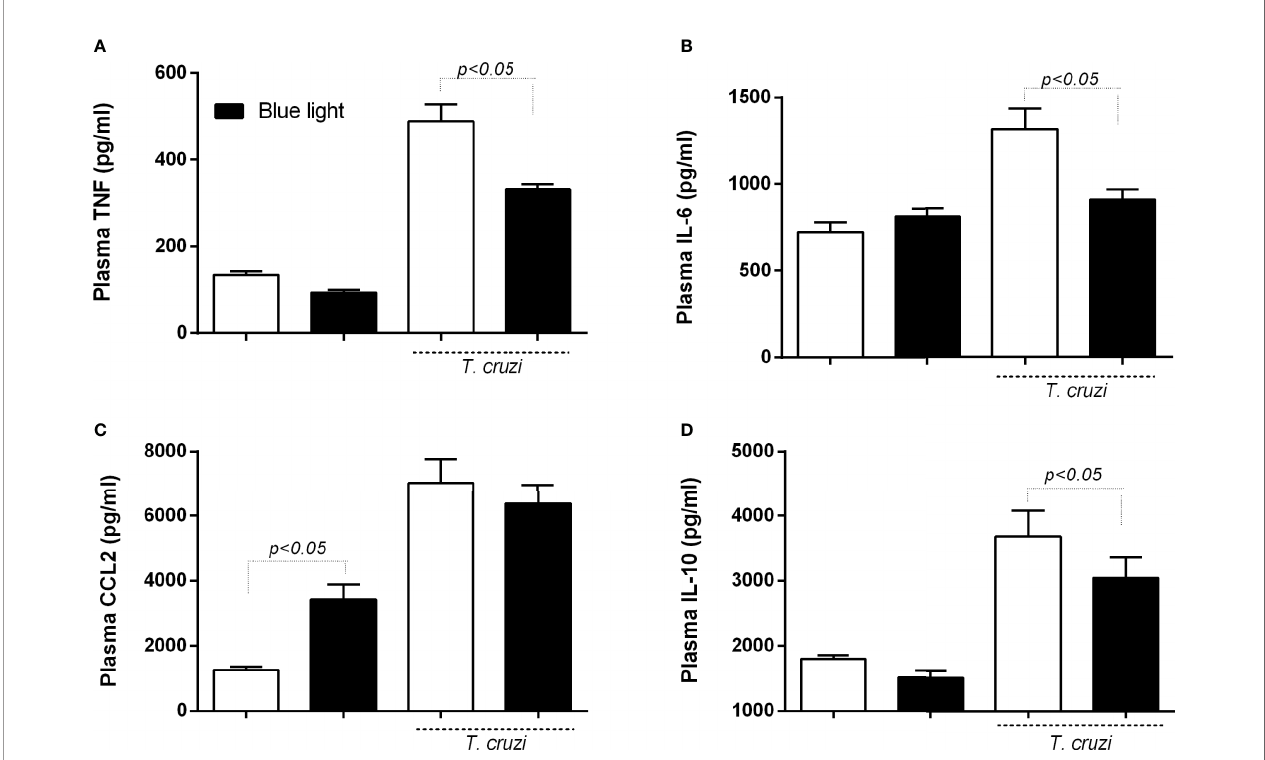
FIGURE 4 | Level of plasma cytokines in C57BL/6 mice under blue light phototherapy. T. cruzi -infected animals were exposed to conventional and blue light for 9 days, 12 h per day. The plasma was collected to evaluate the cytokines TNF (A) , IL-6 (B) , CCL2 (C) and IL-10 (D) production. p<0.05 means differences between infected groups under blue light and conventional